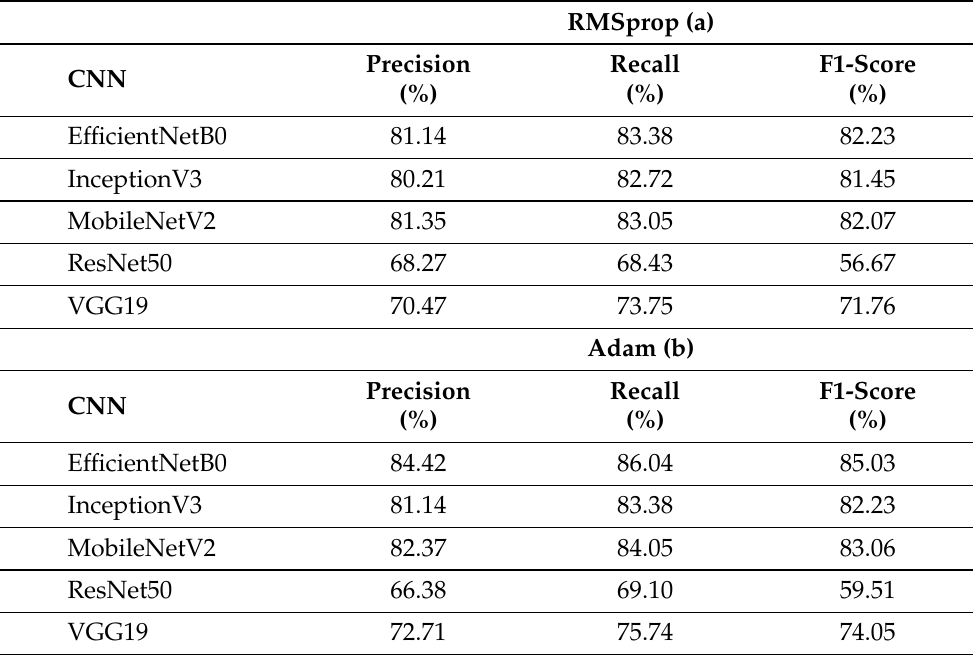
Table 5. Precision, recall and F1-score obtained with RMSprop (a) and Adam (b) optimizers on the test set in the task of classifying the “healthy”, “slug”, “curl” and “spot”